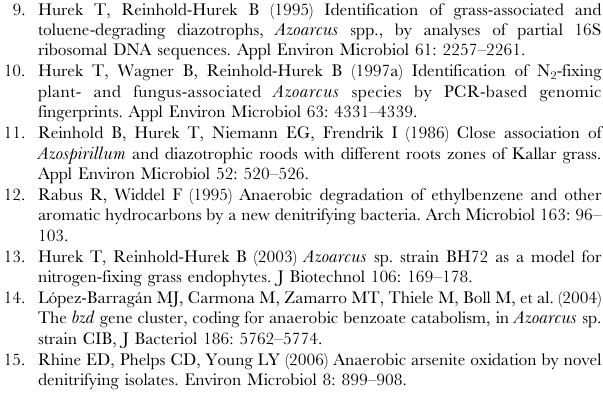
Figure S3 Solubilisation of the low soluble inorganic phosphate by Azoarcus sp. CIB. The halos were observed after 7 days of incubation on solid MALP medium at 30 u